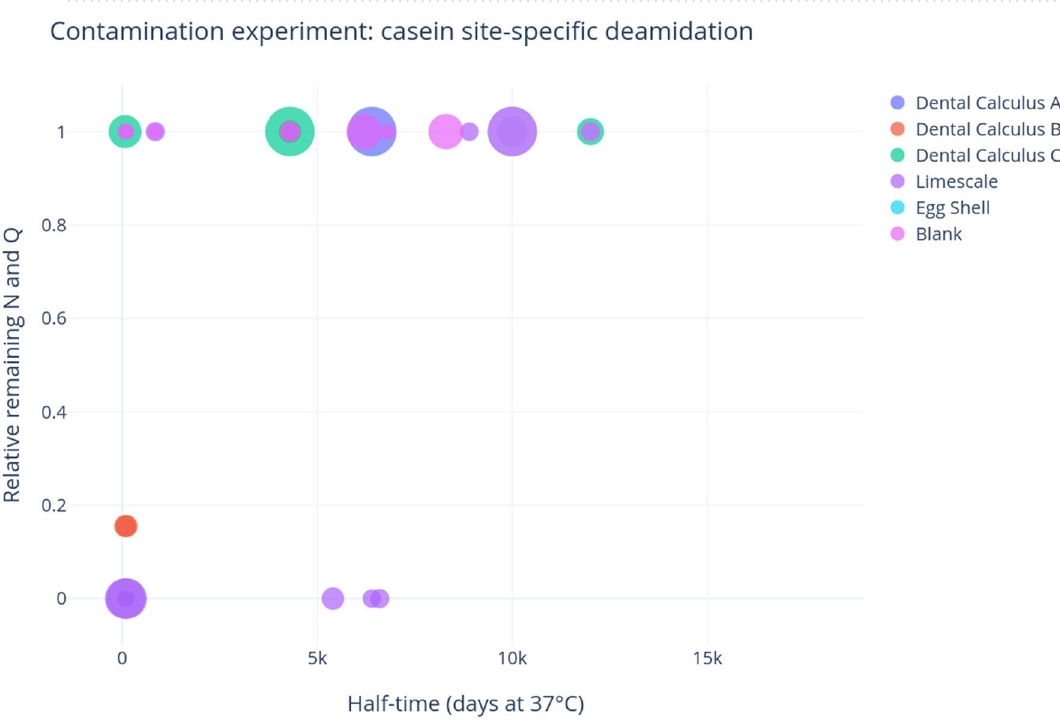
Figure 5. Site-specific deamidation in contamination experiment, where the y-axis represents the proportion of remaining deamidating amino acid, and the x-axis shows the half-time of the sites. The size of the points represents the intensity of the peptide; plots produced through deamiDATE 24